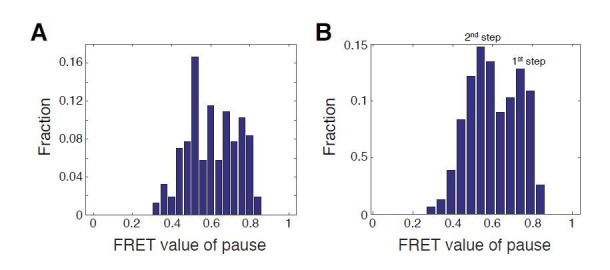
Histograms of FRET values for the p1 and p2 pauses for WT SNF2h with WT nucleosomes.A. Bin positions as in Blosser et al., 2009 (every 0.04 FRET, starting at 0 FRET). B. Bin positions every 0.05 FRET, starting at 0.04 FRET. Due to the non-linearity of our calibration curve, FRET values of pauses are not representative of preferential step locations. We show histograms of FRET values here simply to illustrate the effect of bin choice on the way the data appear, which we chose to do with reference to previously published histograms of FRET values from Blosser et al.,2009.